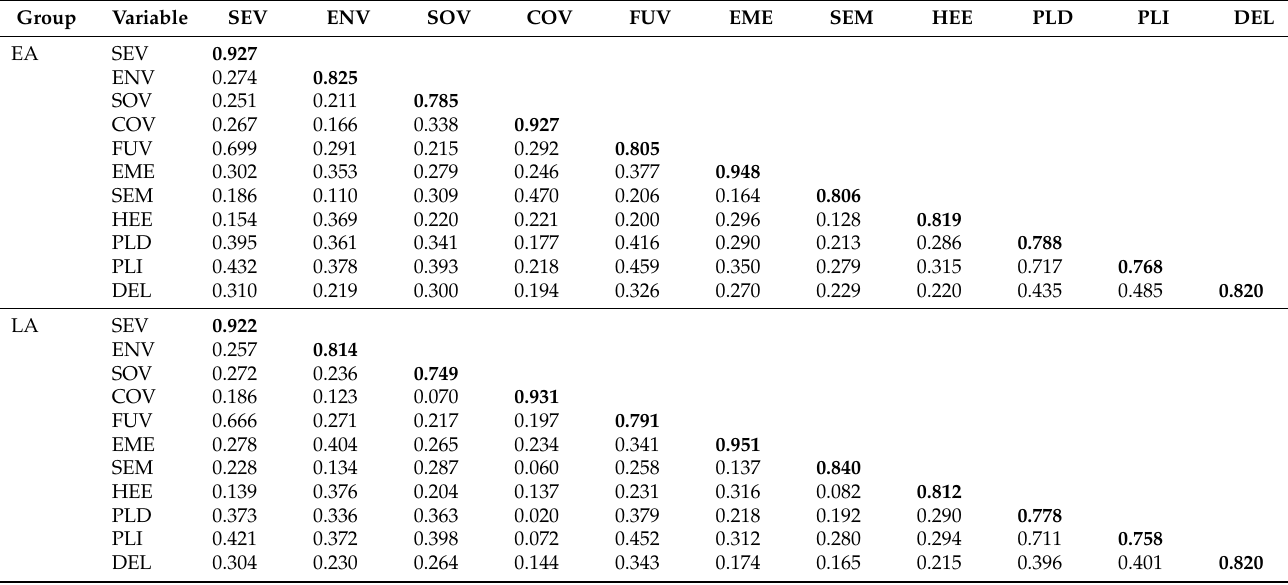
Table A2. Discriminant validity